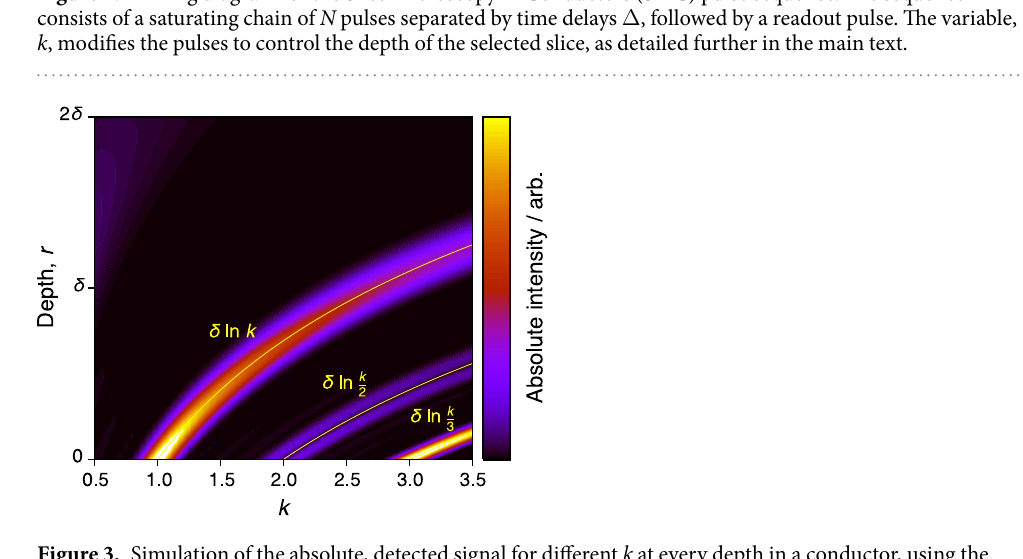
Figure 3. Simulation of the absolute, detected signal for different k at every depth in a conductor, using the SMC sequence with N = 16, Δ = 800 μ s, T 1 = 170 ms, T 2 = 600 μ